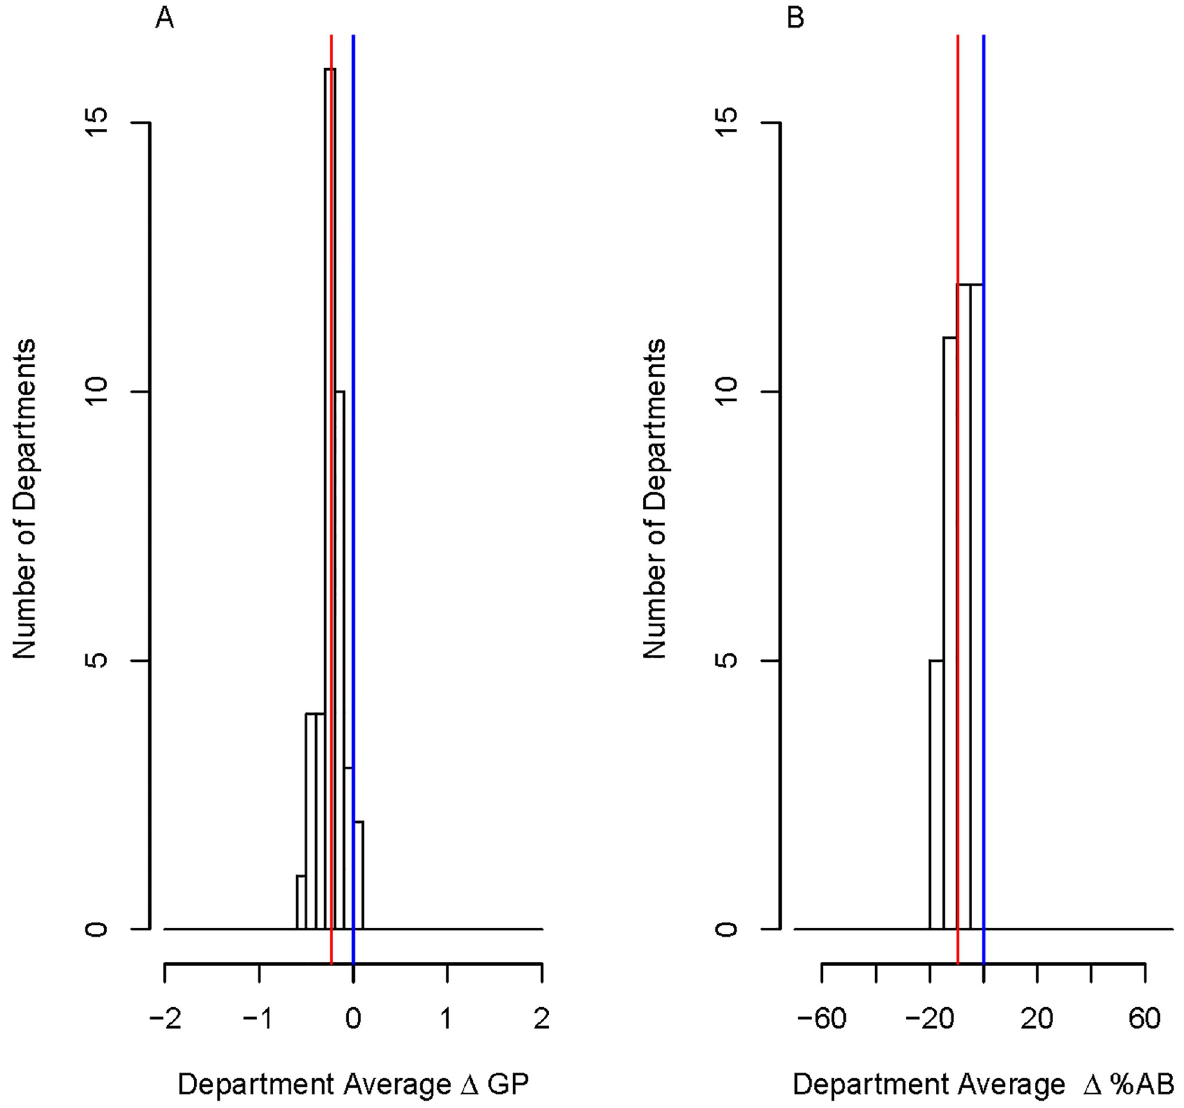
Fig 3. Histograms of the differences in grades (department average Δ GP and Δ %AB) given to PEERs and non-PEERs per course section at the department level. A total of 40 STEM departments are included in the plots. The red line represents the median on each plot and the blue line represents no difference between the two groups. The median STEM-department average for Δ GP is -0.24 and for Δ %AB is -9%.